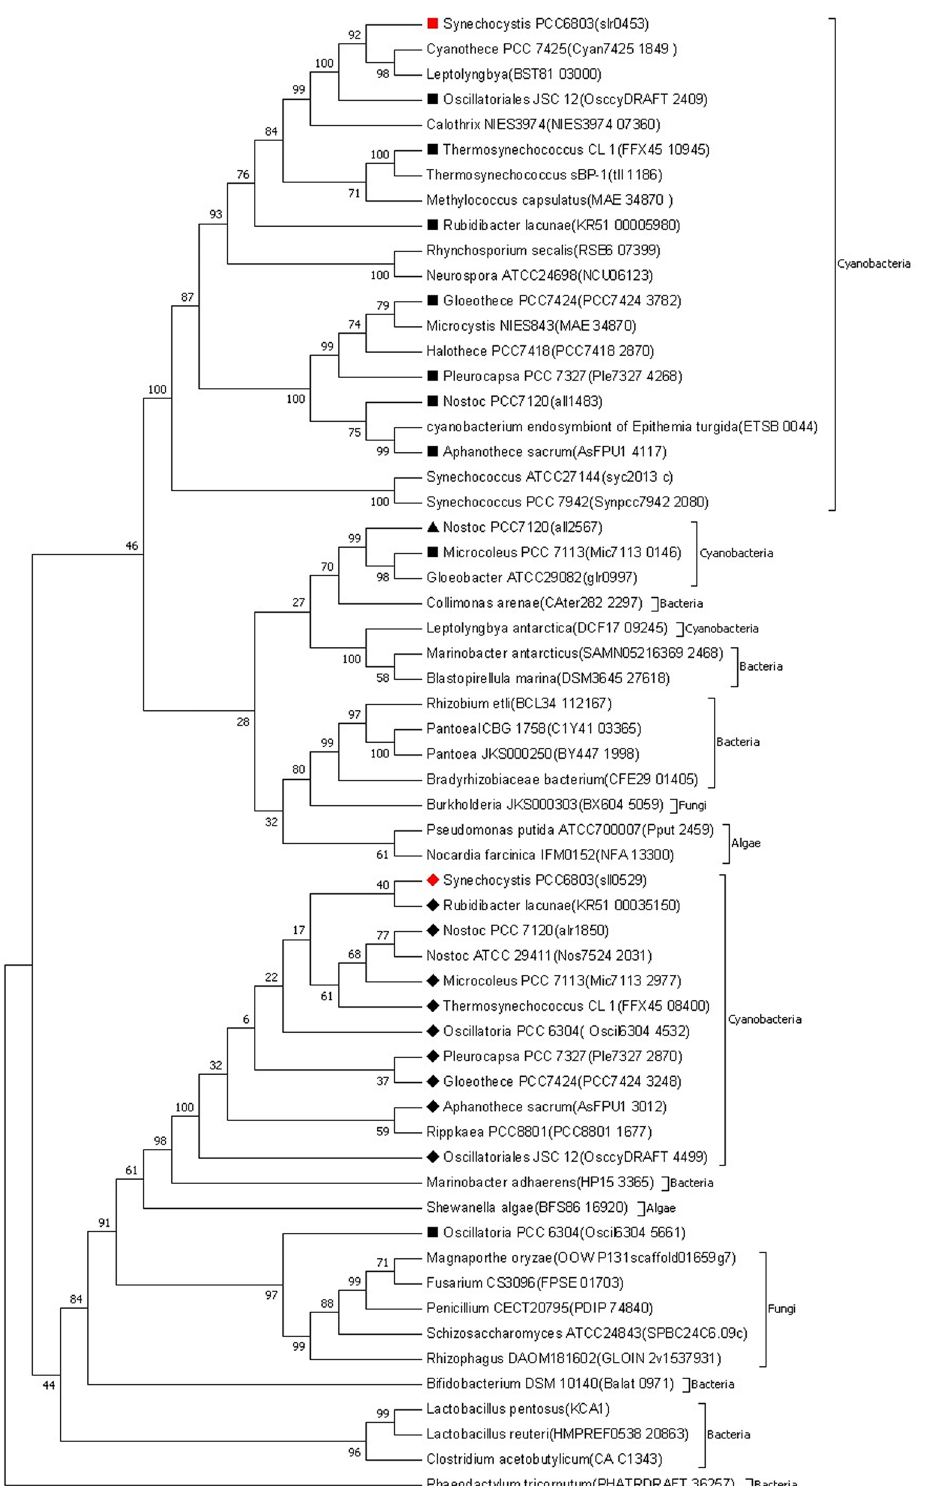
Figure 2. Phylogenetic tree created from the retrieved amino acid sequences of phosphoketolase (PKET) from sequence databases (Uniprot and NCBI) with MEGA 7 using Neighbour joining method (maximum bootstrap value of 500). The evolutionary distances were computed using the JTT matrix-based method. Square, diamond and triangle symbols are showing the first, second and third isozymes of PKET, respectively. Red colour is highlighting Synechocystis